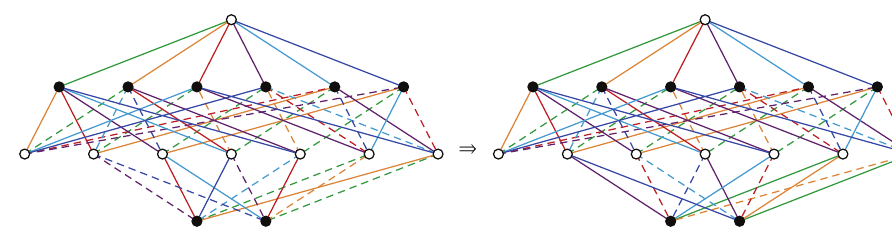
Figure 12: Adinkra after step